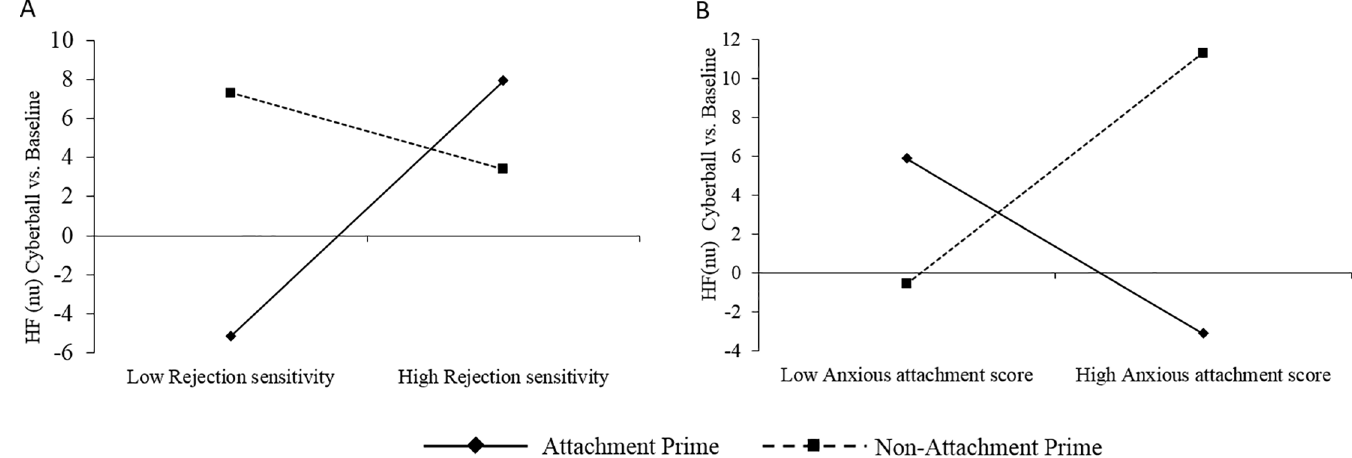
Fig 3. Simple slopes analysis for HF-HRV changes relative to baseline during Cyberball. (3A). Rejection Sensitivity; (3B) Anxious attachment.